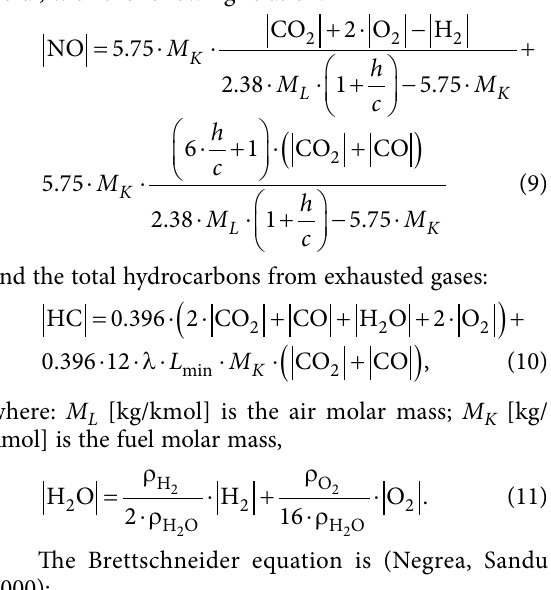
Fig. 5. CO 2 emission versus time for petrol fuel (air conditioning unit is turned off)